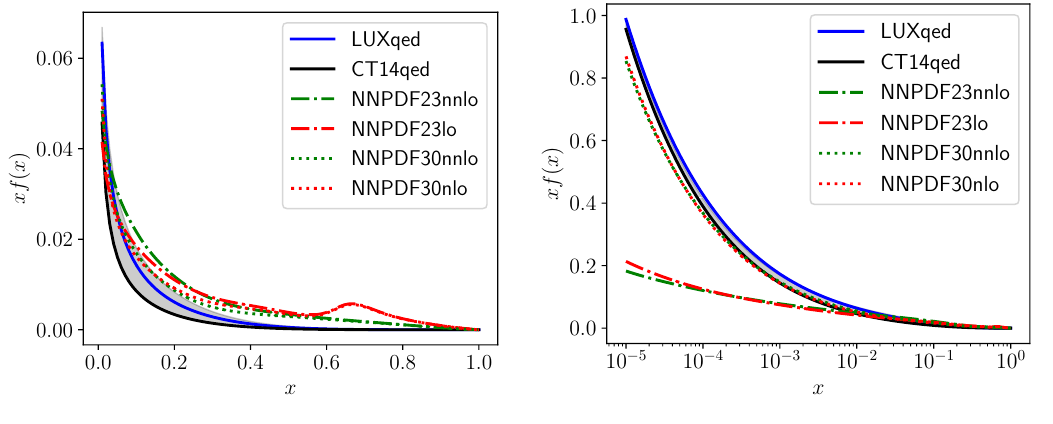
Figure 19 . Same as in (cid:12)gure 18 but for a scale of 1